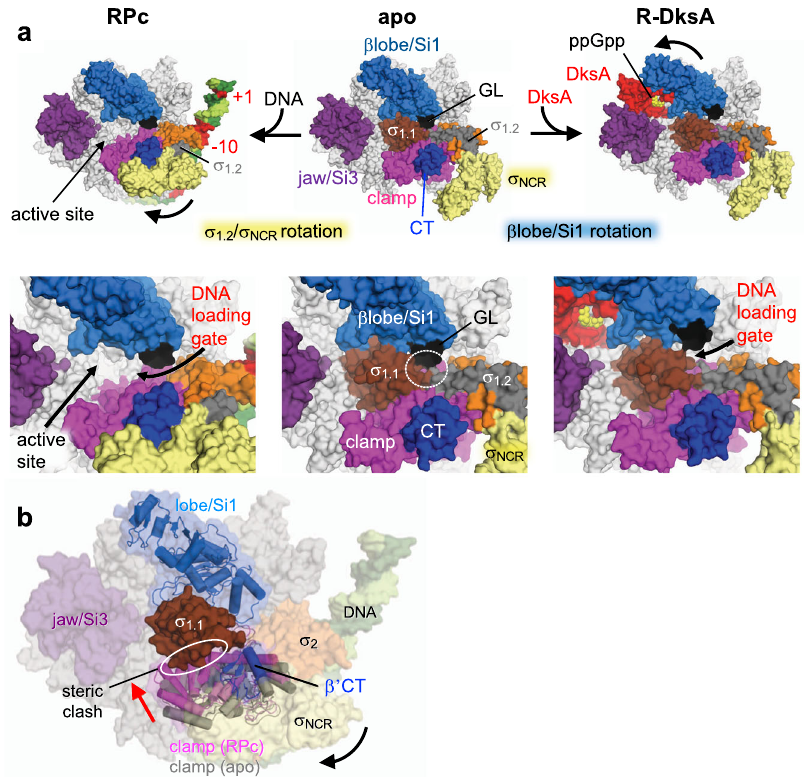
Fig. 5 Opening the DNA loading gate by moving the σ 1.2 / σ NCR or β lobe/Si1 domain. a Comparison of the σ 1.2 / σ NCR and β lobe/Si1 conformations in apo- RNAP (middle), RPc (left), and RNAP-DksA/ppGpp (R-DksA, right, DNA is removed from the RP1-DksA/ppGpp to model this complex). RNAP (subunits and domains), DksA and DNA are indicated. Close-up views of the RNAP cleft are shown below. The DNA loading gate is closed in the apo-RNAP due to the β gate loop ( β GL) contacts with σ 1.1 / σ 1.2 (white dashed oval). The opening of the DNA loading gate in RPc and RP1-DksA/ppGpp is indicated by blue and red arrows, respectively. b A proposed model of σ 1.1 ejection in the RPc. The RPc is depicted as a transparent surface with cartoon models of the clamp (purple) and the lobe/Si1 (blue). The clamp in the apo-form RNAP and the lobe/Si1 in RP1-DksA/ppGpp are colored gray and white, respectively. In the RPc, the σ NCR rotation (black arrow) contacts the β ’ CT, resulting in clamp movement toward σ 1.1 (red arrow) and a steric clash with σ 1.1 (white